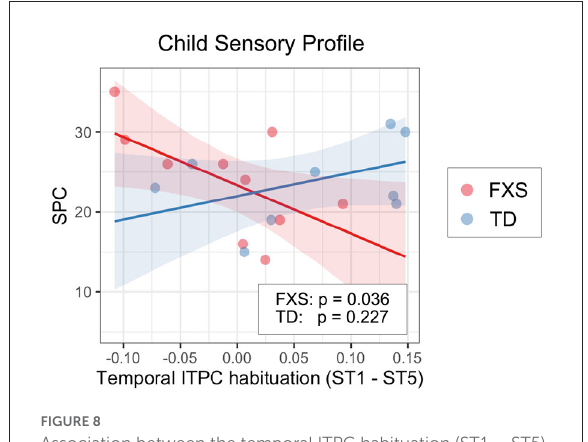
FIGURE8 Association between the temporal ITPC habituation (ST1 – ST5) and SPC in Model 1. The lines and shaded areas denote the prediction lines and their 95% confidence interval estimated by the marginal effect. The scattered dots represent individual data. The unadjusted p -value of marginal effect for each group is shown in the